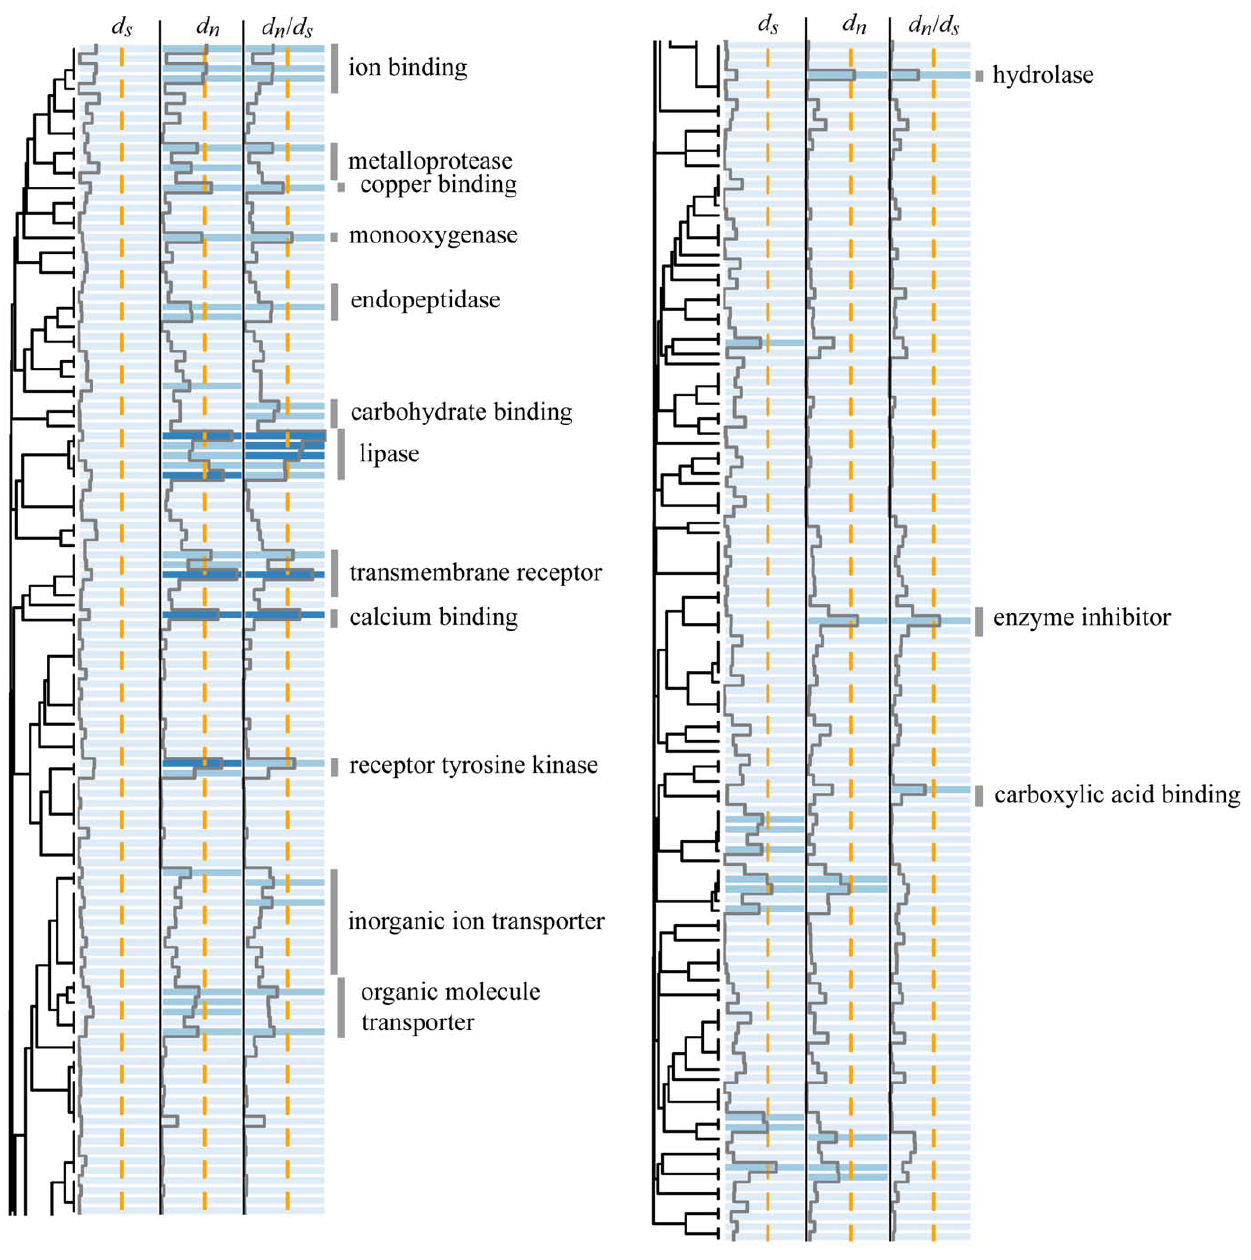
Figure 3. Detection of molecular functions experiencing accelerated protein sequence evolution. The dendrogram reflects the proportion of orthologs shared between different categories in our dataset (see Material and Methods). The colors of the corresponding cells and the overlying trace line represent P -values of Mann-Whitney U test for elevated d S , d N , and d N /d S values. The first transition to the darker color signifies P , 0.05 in an individual comparison. The dashed orange line indicates the 10% false discovery rate cutoff.